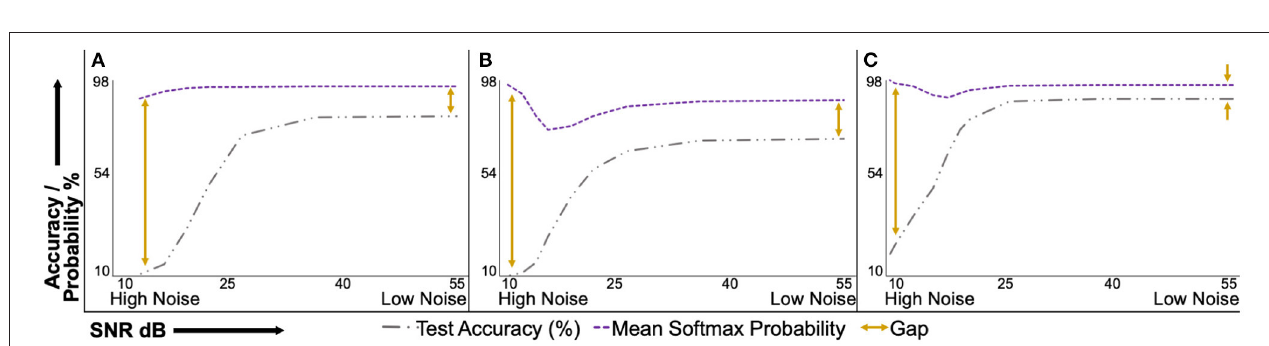
bladder, left femoral head, and right femoral head. The study used segmentation masks provided by LiTS to compute the bounding-box for the liver. The bounding-box for the other organs is annotated and verified by radiologists. The source training set of 131 CT scans is split into training and validation sets with 115 and 16 CT scans, respectively. The source test set of 70 CT scans is used as the test set. Voxel intensities of the 3D scans are transformed from Hounsfield-Unit (HU) into gray-scale. OrganAMNIST dataset is the 2D images cropped from the center slices of the 3D bounding-boxes in axial view (plane). The source images are resized to 1 × 28 × 28. The sample images of each dataset are shown in Figure 4